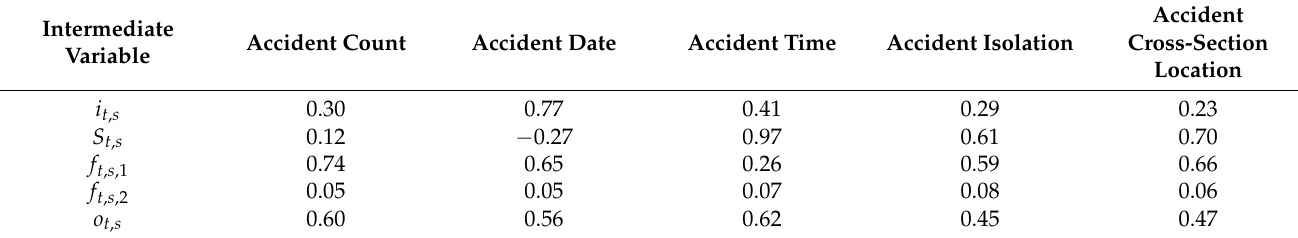
Table 5. The value of intermediate variables of the grid cell (50, Figure 12. ( a ) The spatial distribution of the potential of accident time . ( b ) The spatial distribution of the isolation form.